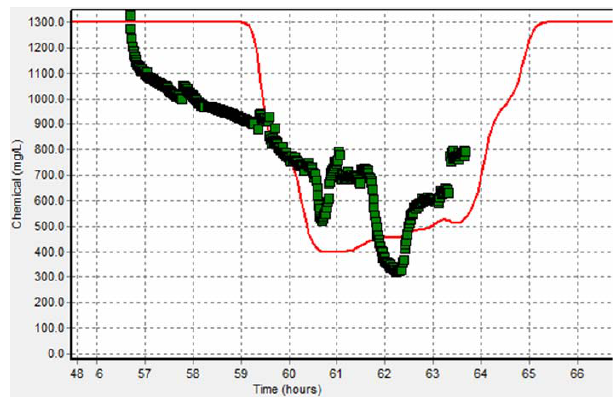
Figure 3. Measured (green squares) and modeled (red line) con- centrations of the tracer near RPM measurement location No. 3 (see Fig. 1).